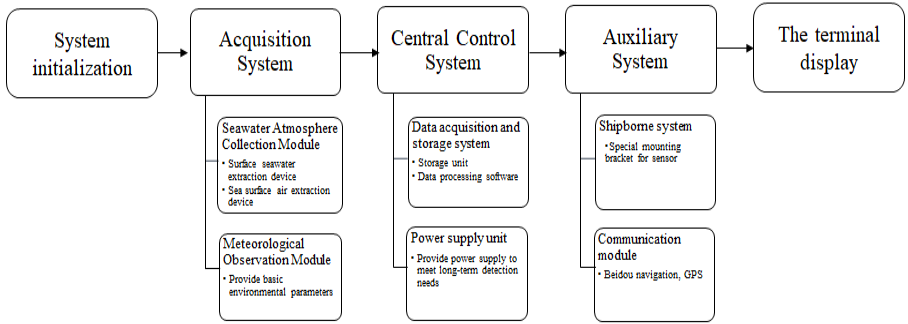
Figure 1. System architecture diagram.